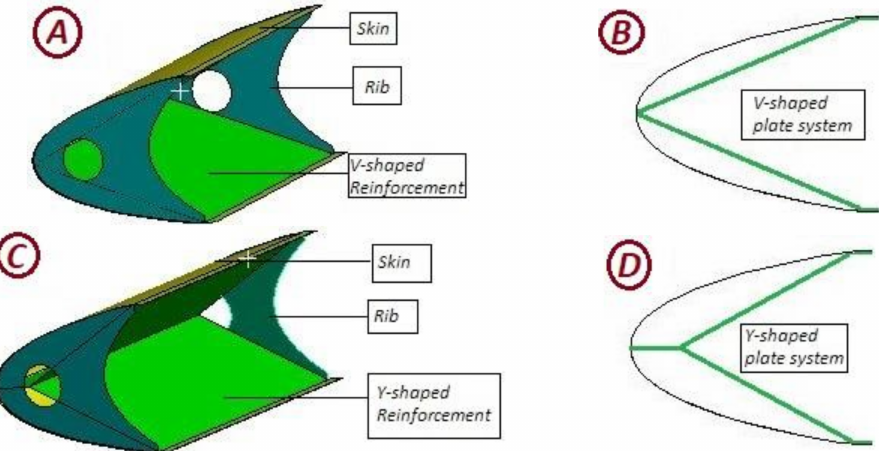
Figure 3. Structurally reinforced anti-bird-strike system. ( A ) V-shaped reinforcement; ( B ) Side view of V-shaped reinforcement; ( C ) Y-shaped reinforcement; ( D ) Side view of Y-shaped